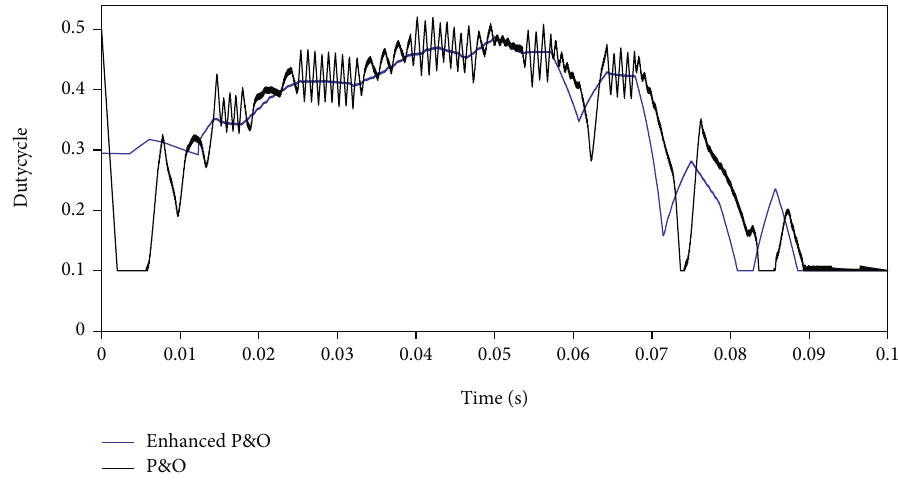
Figure 25: Duty-cycle control according to the P&O and the enhanced P&O MPPT under real